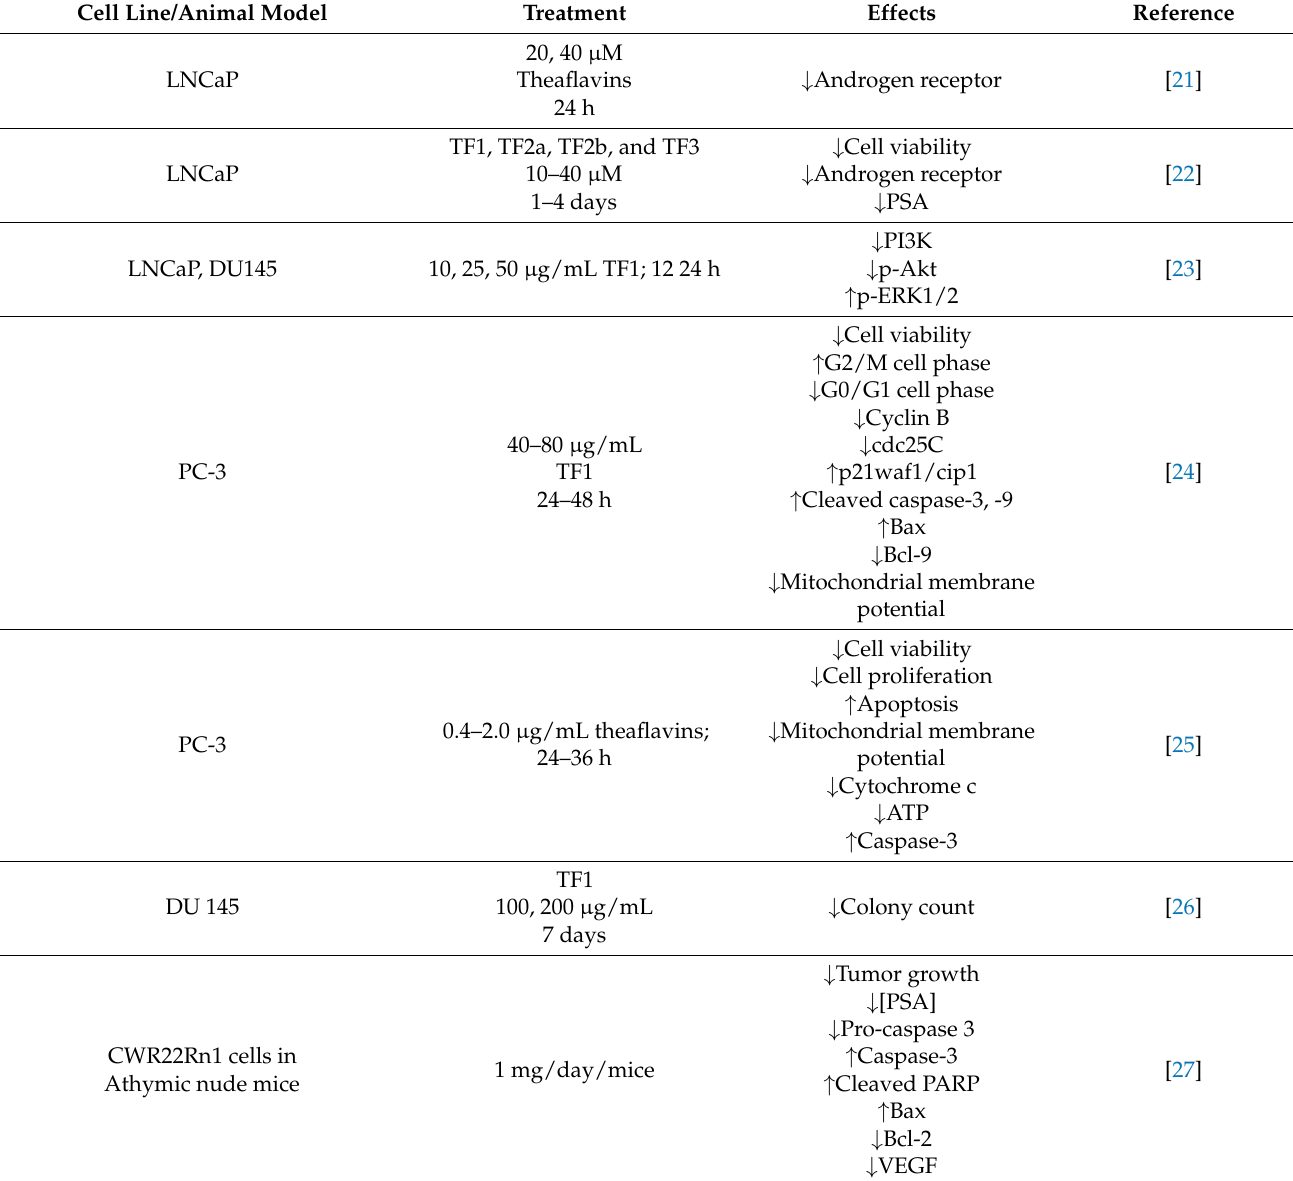
Table 2. Effects of theaflavins in prostate